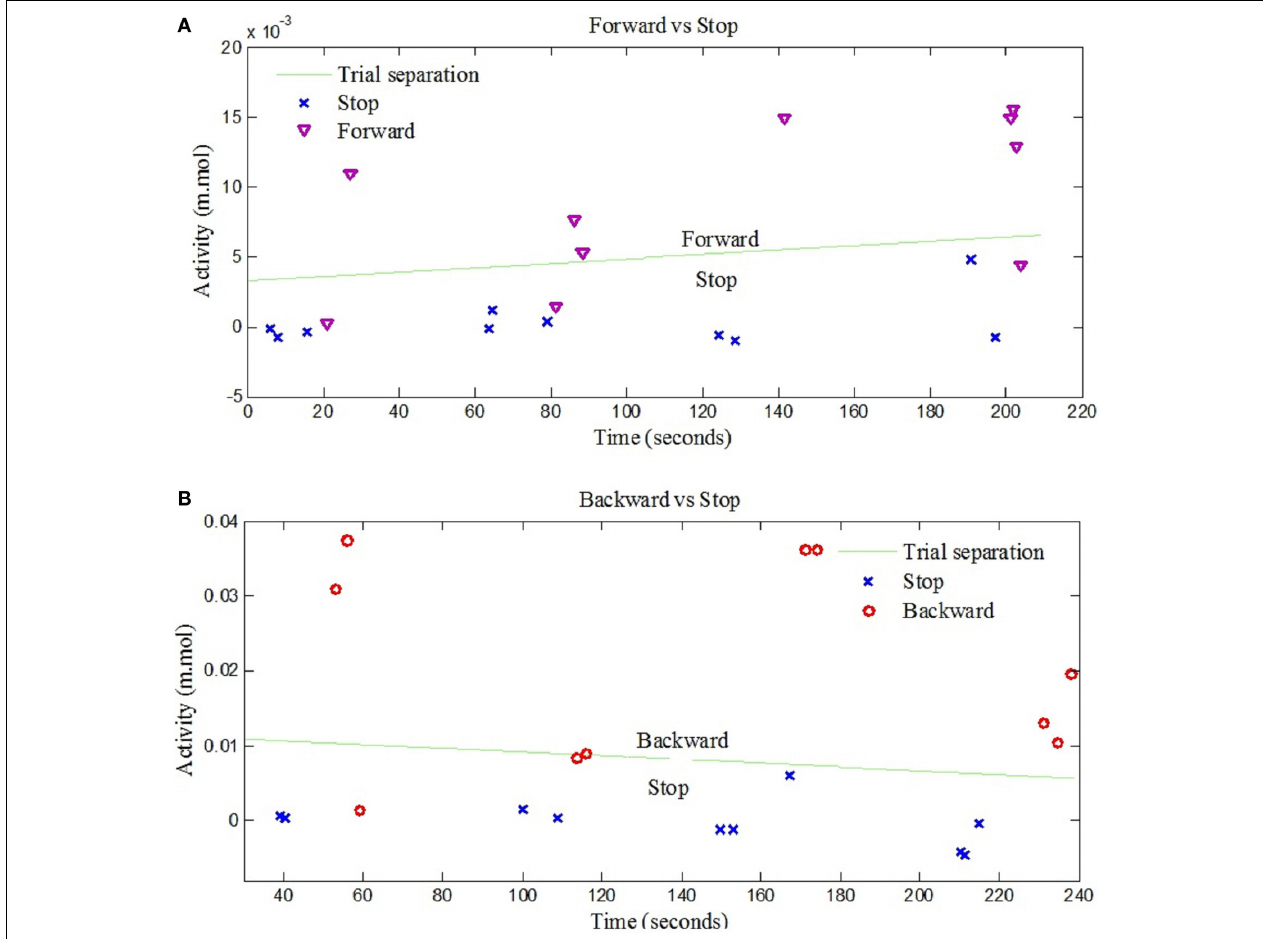
FIGURE 7 | NIRS data classification for forward and backward control commands. (A) Shows the classification of trials for “Forward” and “Stop” command signals for Subject 3, (B) Shows the classification of trials for “Backward” and “Stop” command signals for Subject